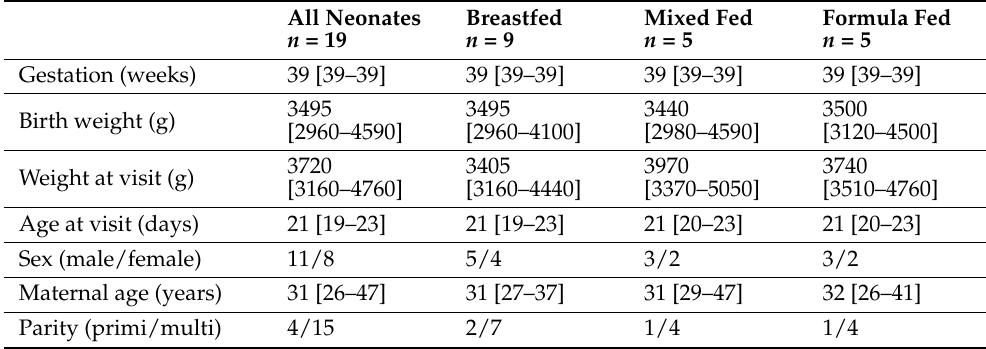
Table 1. Anthropometric and pregnancy characteristics of participating neonates and mothers. Data are presented as median [range] or